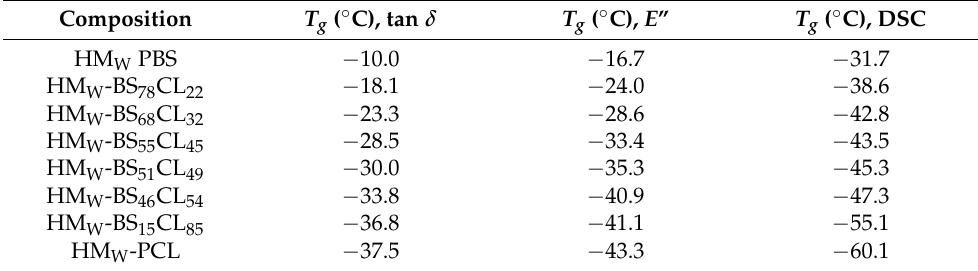
Figure 16. ( a ) Loss tangent (tan δ ) of the copolyesters as a function of temperature at a constant heating rate (4 ◦ C/min) and frequency (1 Hz). ( b ) T g values of HM W -BS x CL y copolyesters (scattered data) as a function of in CL-units content (% molar) and their fitting in the Fox equation (solid black line). Table 1. T g values of HM W PBS- ran -PCL copolyesters extracted from the tan δ peak and E ” of DMTA, and DSC